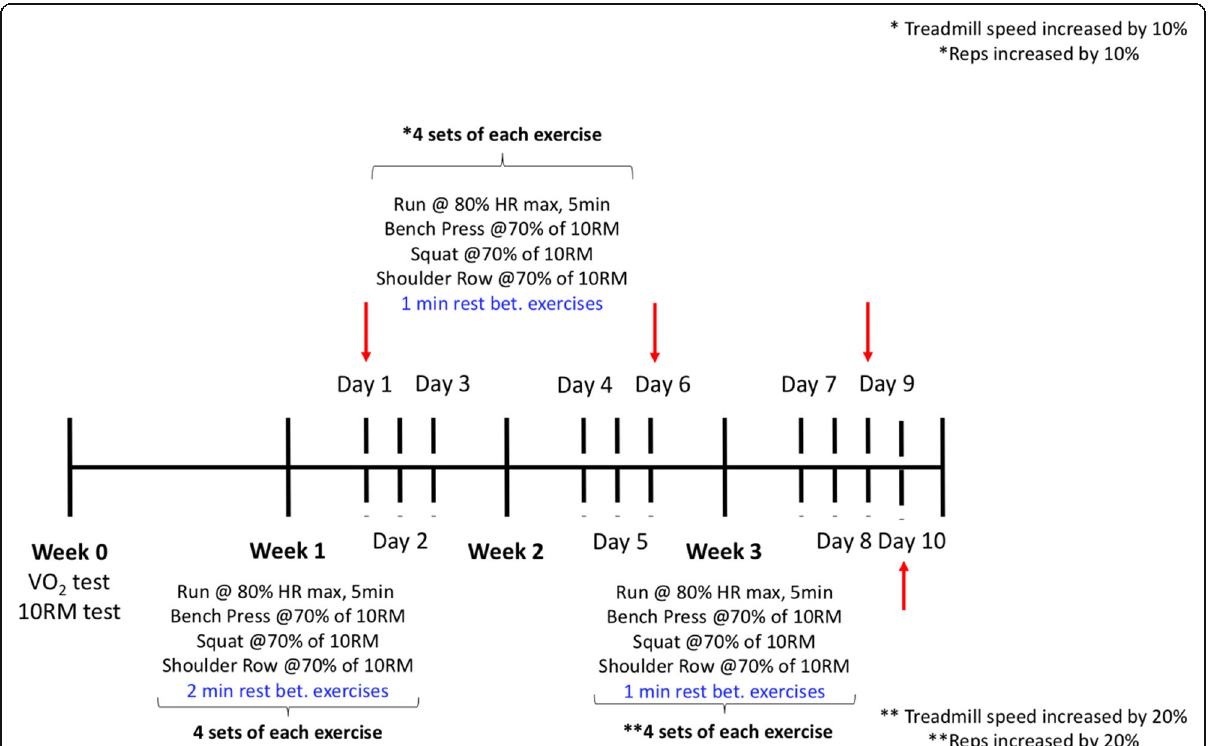
Fig. 1 Schematic overview of the study design. Days 1 – 3 represent the 3 consecutive days of training in week 1, days 4 – 6 in week 2, and days 7 – 9 in week 3 correspondingly. Day 10 represents the 24 h timepoint where participants return to the laboratory for a resting biospecimen collection. All biological sampling timepoints are indicated by red